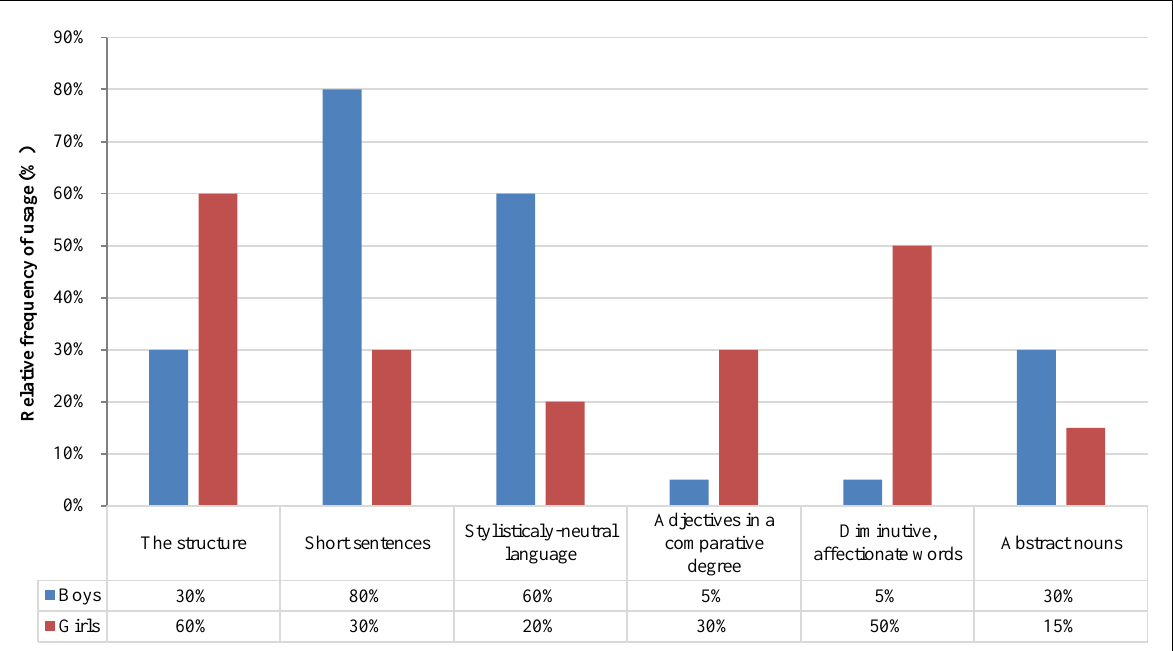
Figure 1. Comparative analysis results of linguistic behavior (gender